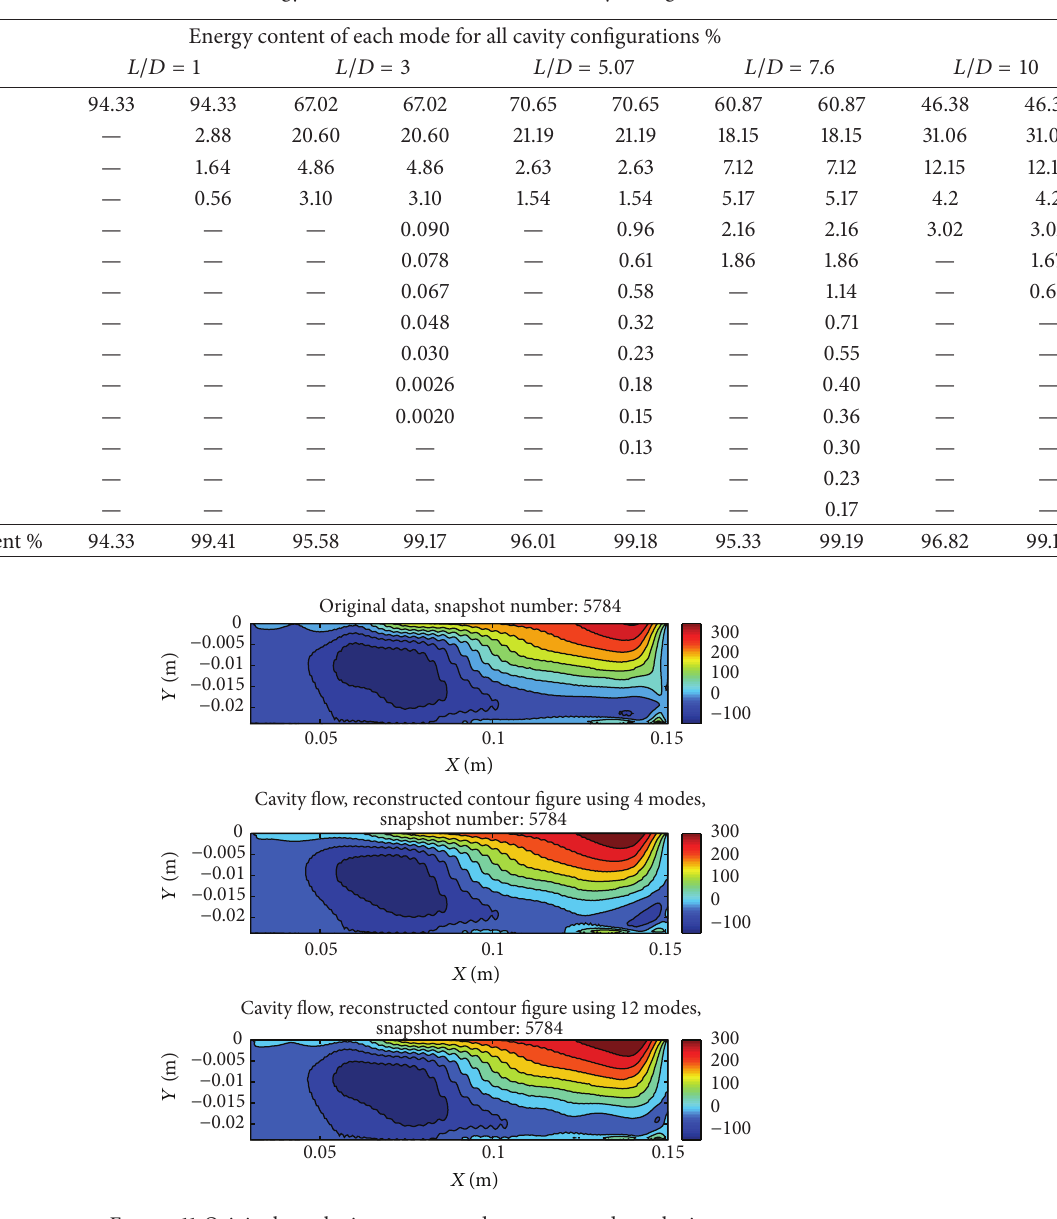
Table 6: Energy content of each mode for all cavity configurations.